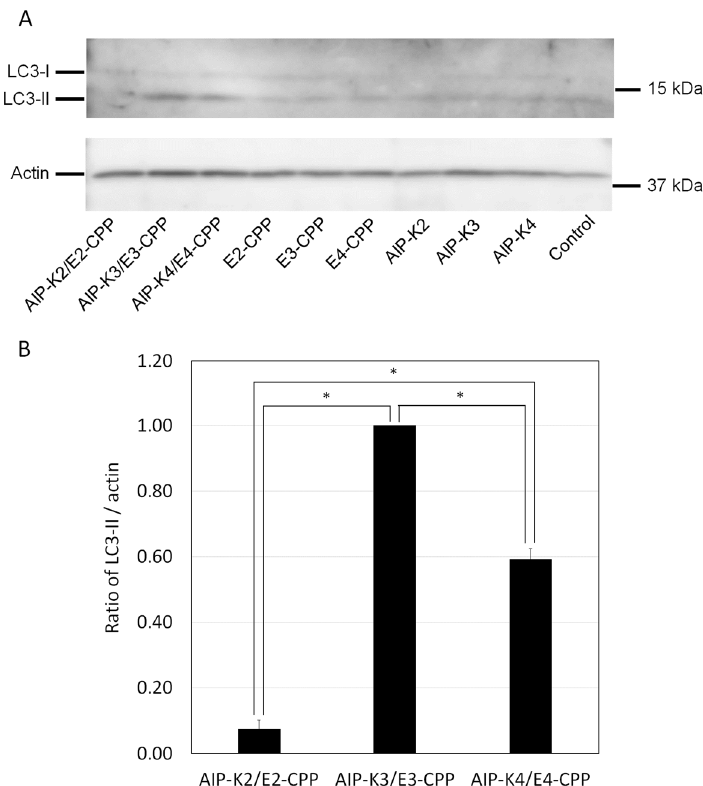
Figure 4. ( A ) Autophagy induction after treatment by the AIP-Kn/En-CPP hybrid, AIP-Kn, and En- CPP (n = 2, 3, and 4). Cells were treated with 10 µM of the indicated hybrids or peptides. Molecular weights of standards are shown on the right side of each membrane. ( B ) Level of the autophagy marker LC3-II in cells. The band intensity of LC3-II and actin in immunoblo tt ing was quanti fi ed and the LC3-II/actin ratio was calculated. Actin was used for normalizing the loading amount. The LC3- II/actin ratio for AIP-K3/E3-CPP was set to 1.00. The graph presents the mean with standard error from three independent experiments. * p < 0.0001; p -values were calculated using one-way ANOVA with Bonferroni’s multiple comparison tests.